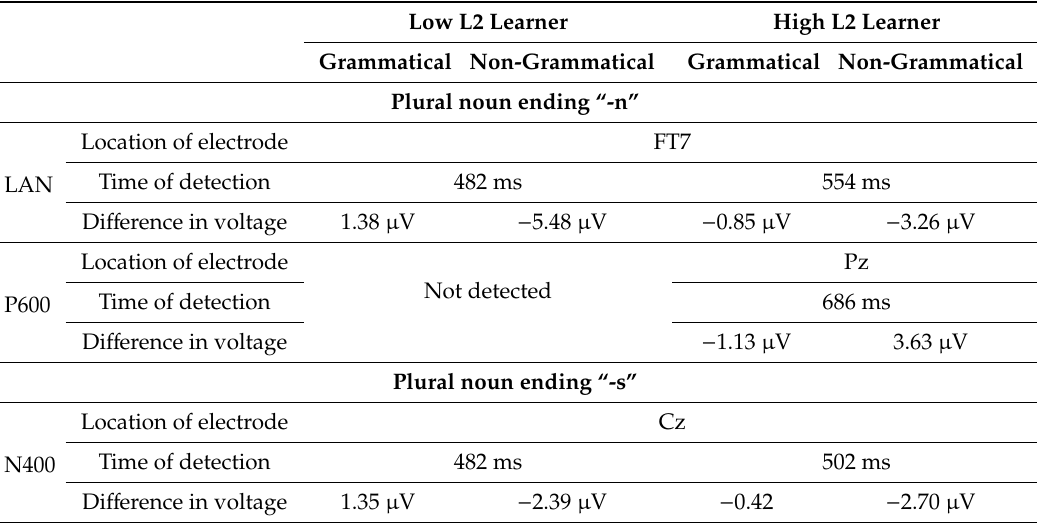
Table 4. Event-related potential (ERP) results by learning level.